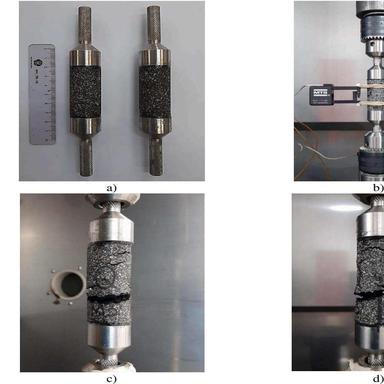
FAM samples: a) after gluing the metal plates and ready to be tested in the servo-hydraulic machine, b) installed in the machine and ready to be tested, c) and d) after tested to identify the cracks developed.